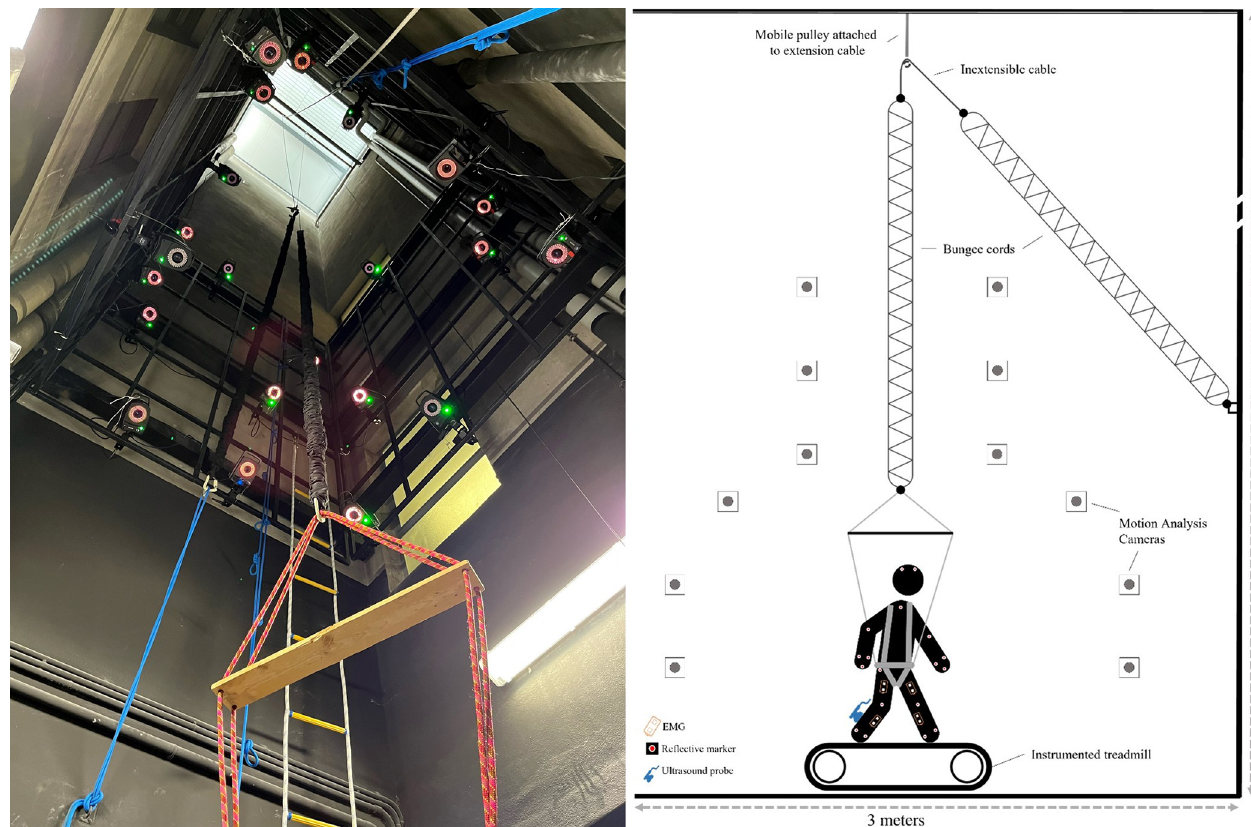
Fig 2. L.O.O.P. facility. Left : Picture of the cavaedium wherein the L.O.O.P has been installed, showing the two bungee cords, the inextensible short cable linking both bungee cords, and several of the motion analysis cameras. Right : Schematic of the experimental setup showing a participant in the harness connected to the bungee cords, walking on the treadmill in the middle of the capture environment and equipped with the EMG-sensors, reflective markers, and ultrasound probe.